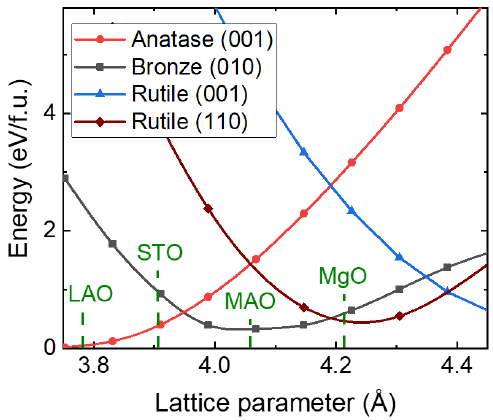
Figure 4. Calculated total energies per formula unit of TiO 2 as a function of the in-plane lattice parameter a sub . The epitaxial relationships considered are biaxial strains within in the anatase (001) plane, bronze (010) plane, rutile (001) plane and rutile (110) plane. Pseudocubic lattice parameters of standard single-crystal substrates are marked for reference. The total energies are given with respect to the ground state energy of the anatase bulk